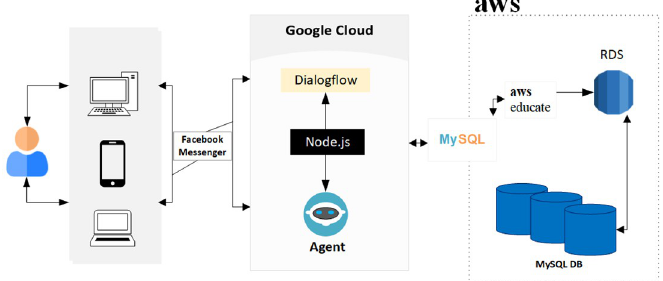
Fig 1. Schematic diagram of DEPRA—Design of the